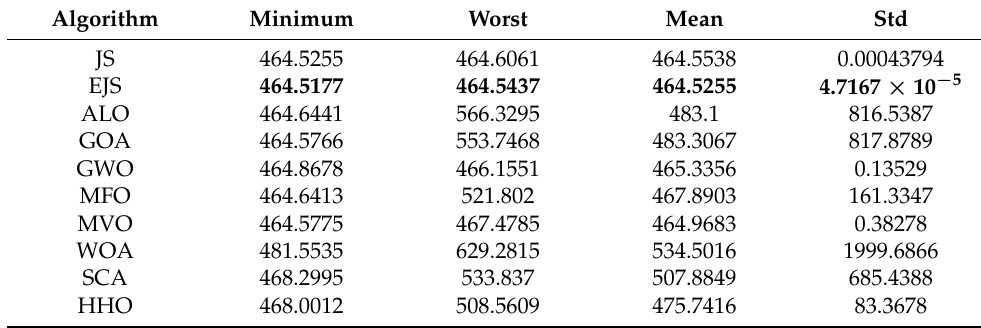
Table 12. Evaluation indicators of all the algorithms for Figure